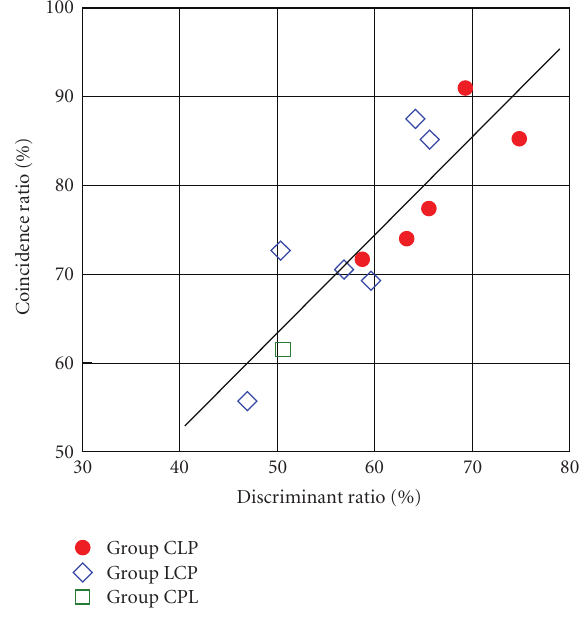
Figure 26: Relationship between discriminant ratio and coinci- dence ratio of each